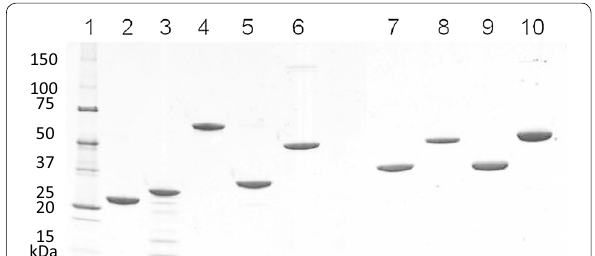
Fig. 2 A SDS-PAGE showing the purification of the different pathway enzymes. A 10% SDS-PAGE gel was stained with Coomassie Blue. Lane 1 molecular weight marker proteins; lane 2, purified Cc XylB; lane 3, purified Cc XylC; lane 4, purified Cc XylD; lane 5, purified Ec YagE; lane 6, purified Ec AldA; lane 7, purified Ec FucO; lane 8,